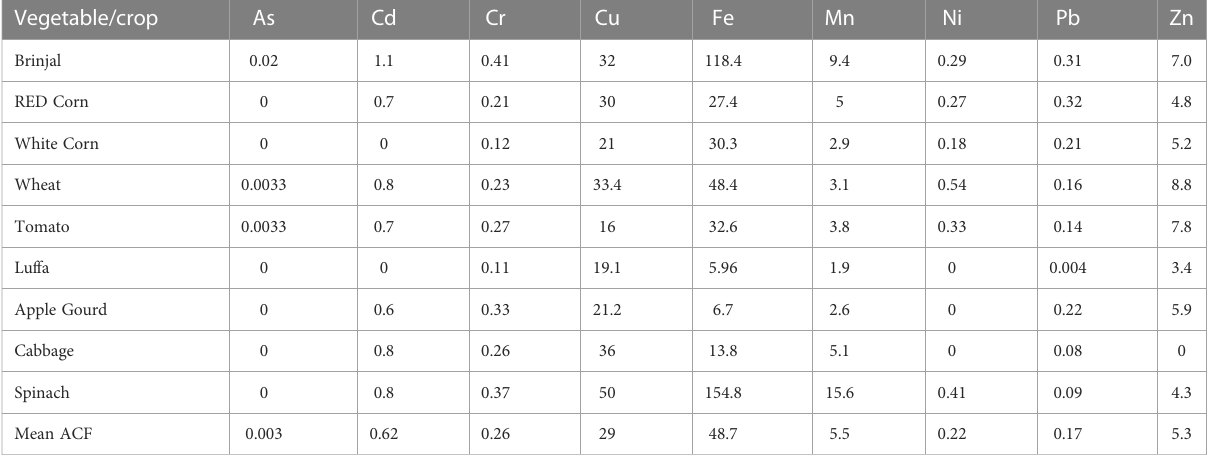
TABLE 3 Accumulation factor of metal content (ACF) from soil to plant. Vegetable/crop